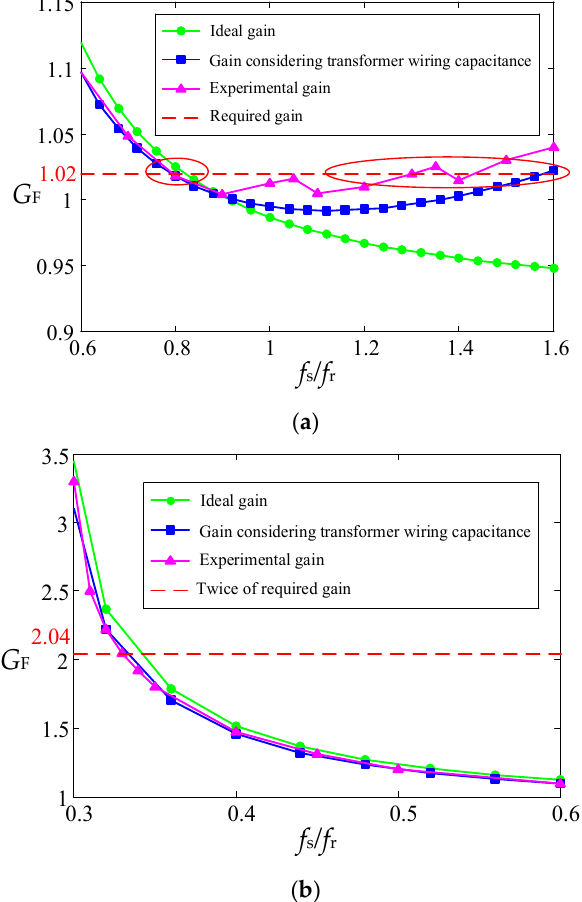
Figure 7. Voltage gain curve of full-bridge CLTC converter at light load condition. ( a ) Around gain of 1.02; ( b ) around again of 2.04.